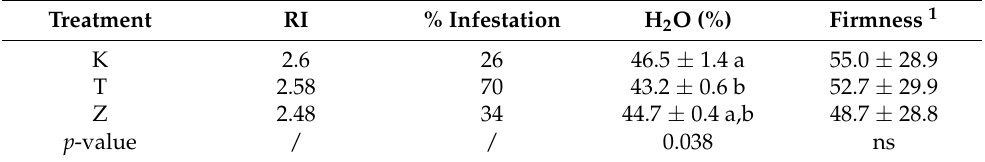
Table 3. Ripening index (RI), percentage of olive fruit fly infestation, water content and fruit firmness in olive from trees treated withK (kaolin), Z (CHA-zeolitite), and T (control). Data are presented as mean ± standard deviation. Different letters in the same column (a,b,c) indicate significant differences according to ANOVA and Tukey’s HSD test ( p < 0.05).